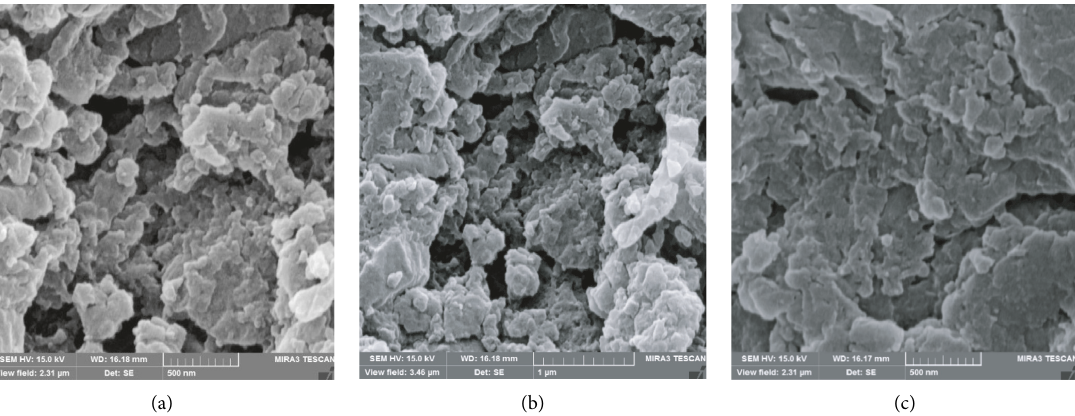
Figure 1: SEM image of chitosan SPME-MIP fiber with the magnification of 60.0kx (a), 90.0kx (b), and SEM image of NIP